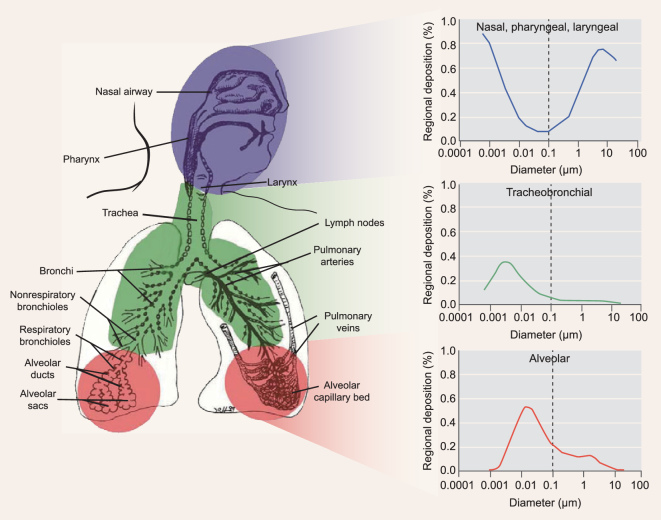
Predicted fractional deposition of inhaled particles in the nasopharyngeal and laryngeal, tracheobronchial and alveolar regions of the human respiratory tract during nose breathing. Please note the clear changes in the deposition rate at these lung regions between nano-sized particles and their larger counterparts. The figure was originally published by [23].